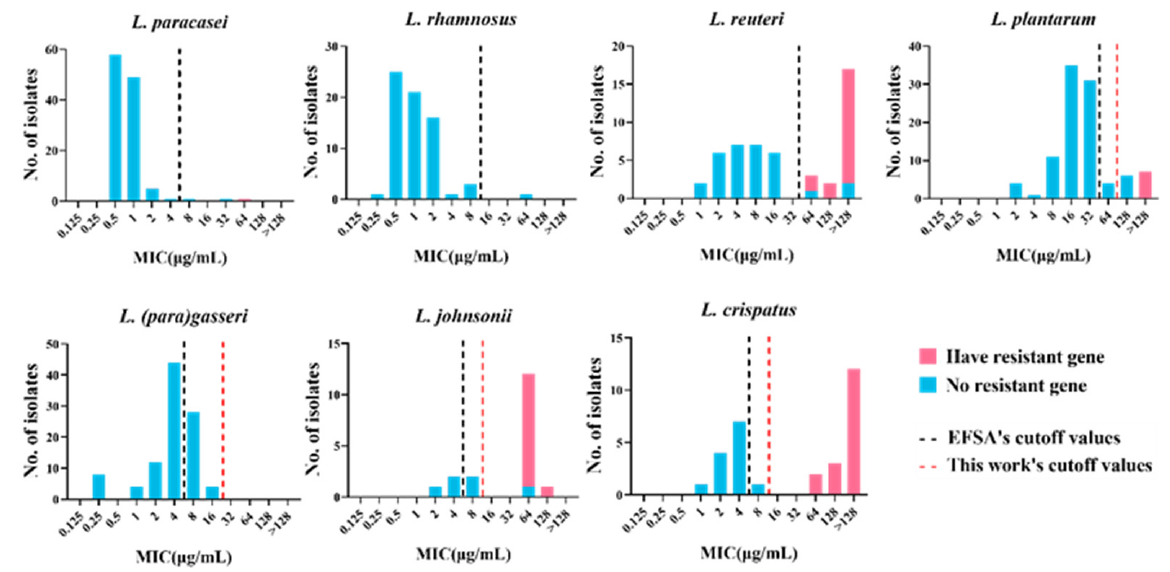
Figure 3. MIC distribution of 478 lactic acid bacteria strains with or without the tetracycline resistance gene. Blue: strains without resistance gene. Pink: strains with the tetracycline resistance gene. Black dotted line: cutoff value established by EFSA. Red dotted line: the new cutoff value established by this work.